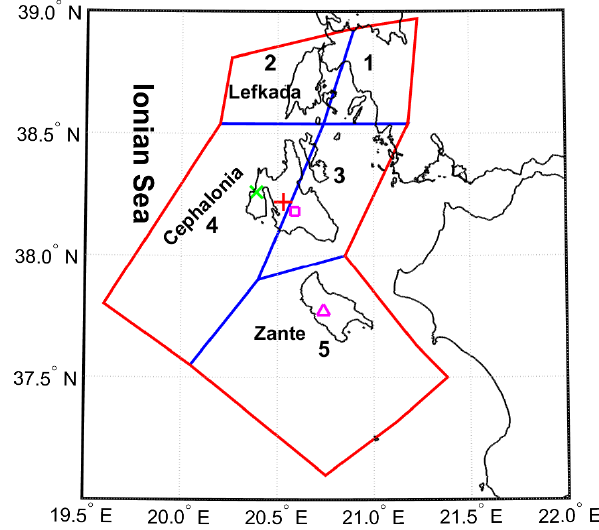
Figure 8. Seismic zonation in the Ionian Islands area. The locations of the Cephalonia and Zante stations, as well as the epicentres of the two significant EQs of interest, are marked using the same signs presented in Fig.